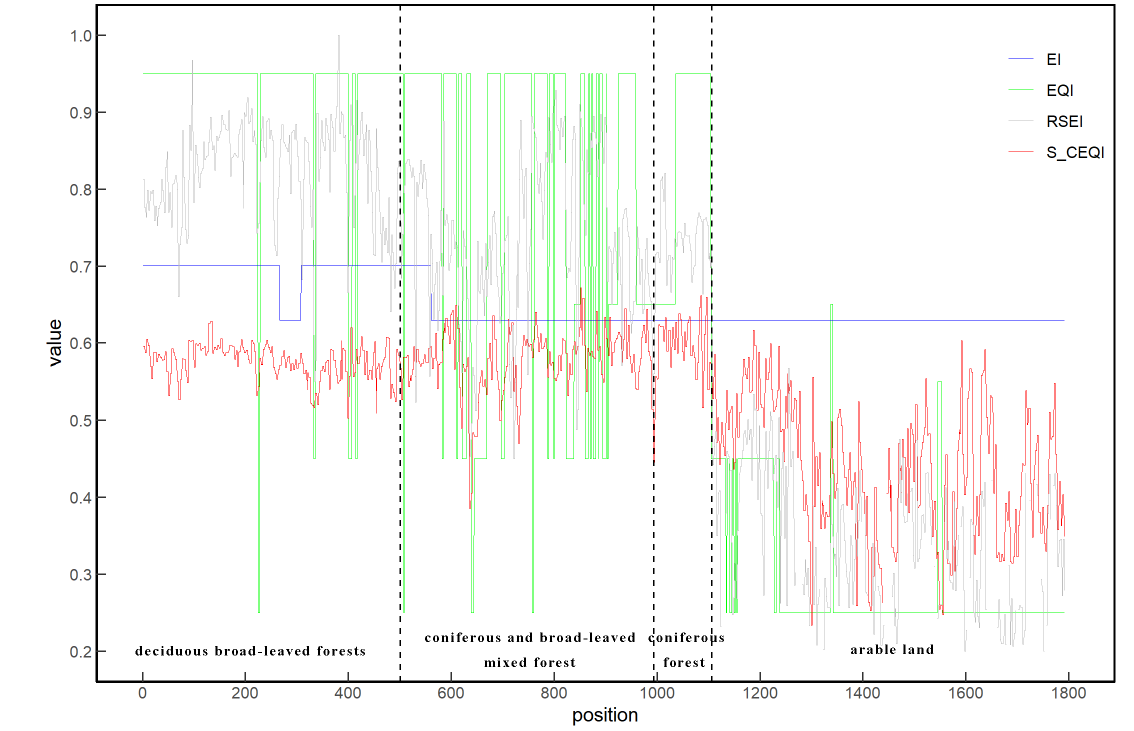
Figure 10. Profile map of the results of the three models ( EI , EQI , RSEI , and S CEQI ). Sample